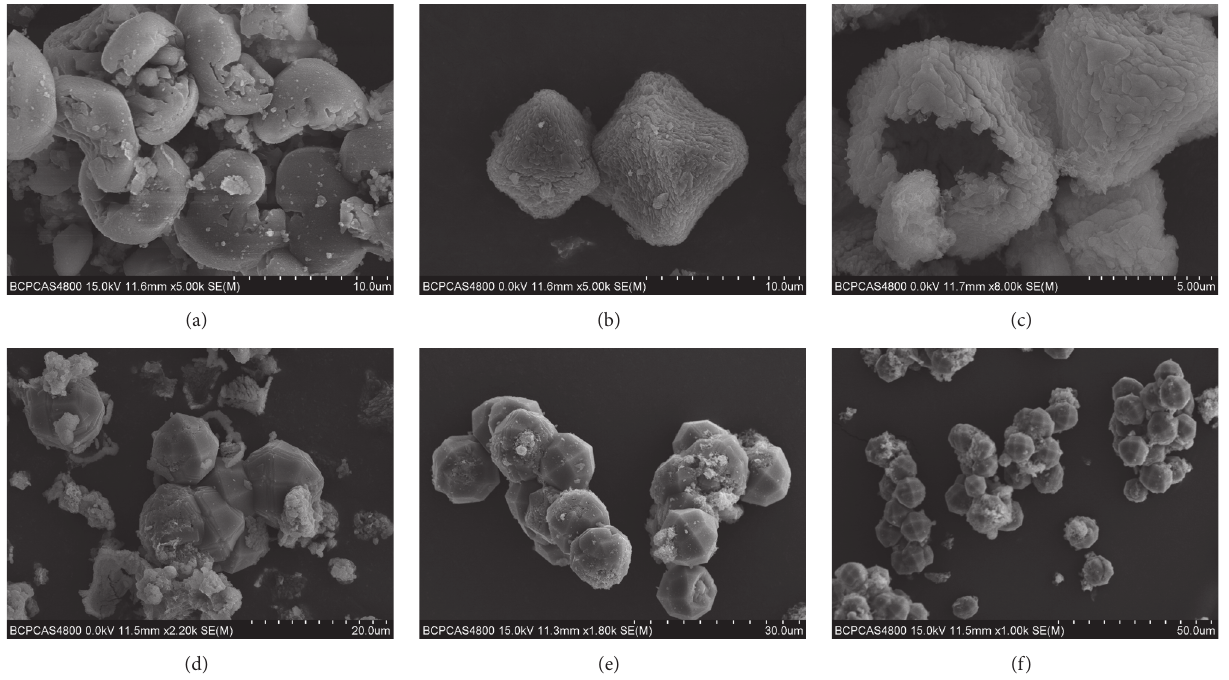
Figure 9: SEM images of samples collected at different crystallization time: (a) 1h, (b) 2 h, (c) 3 h, (d) 3h, (e) 4h, and (f) 5